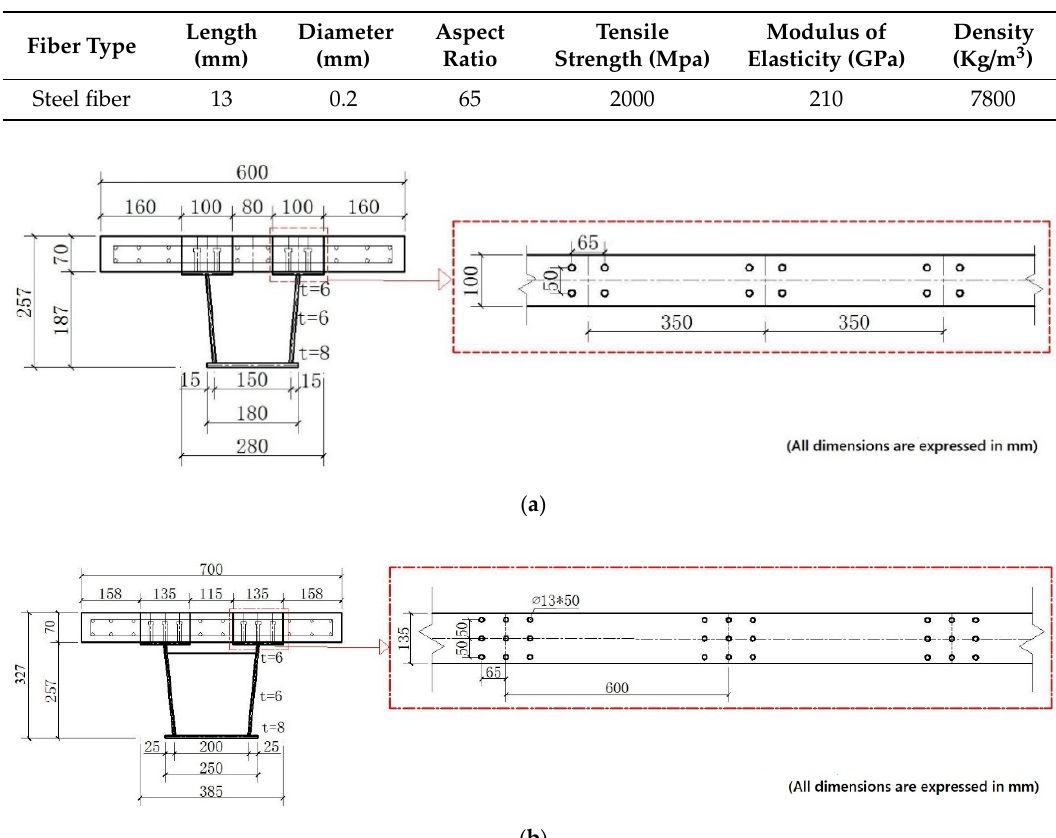
Table 3. Physical properties of steel fibers.